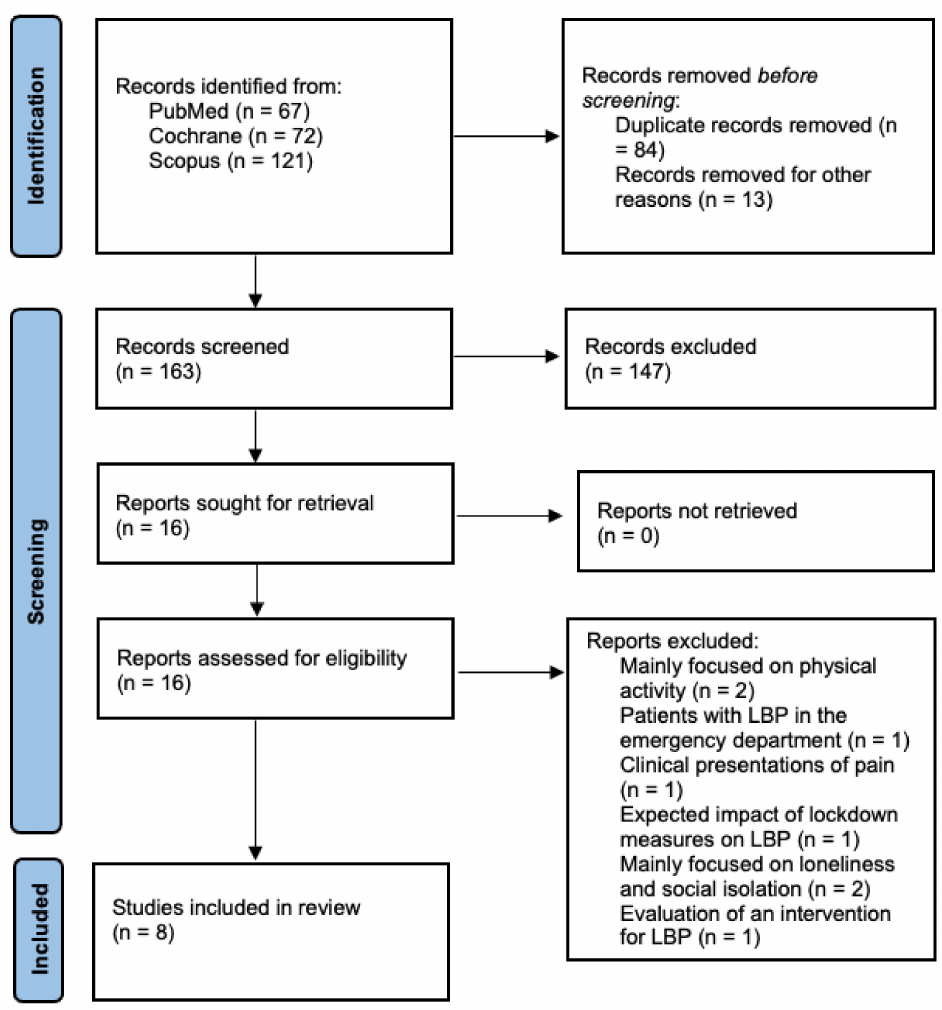
Figure 1. Preferred reporting items for systematic review and meta-analysis (PRISMA